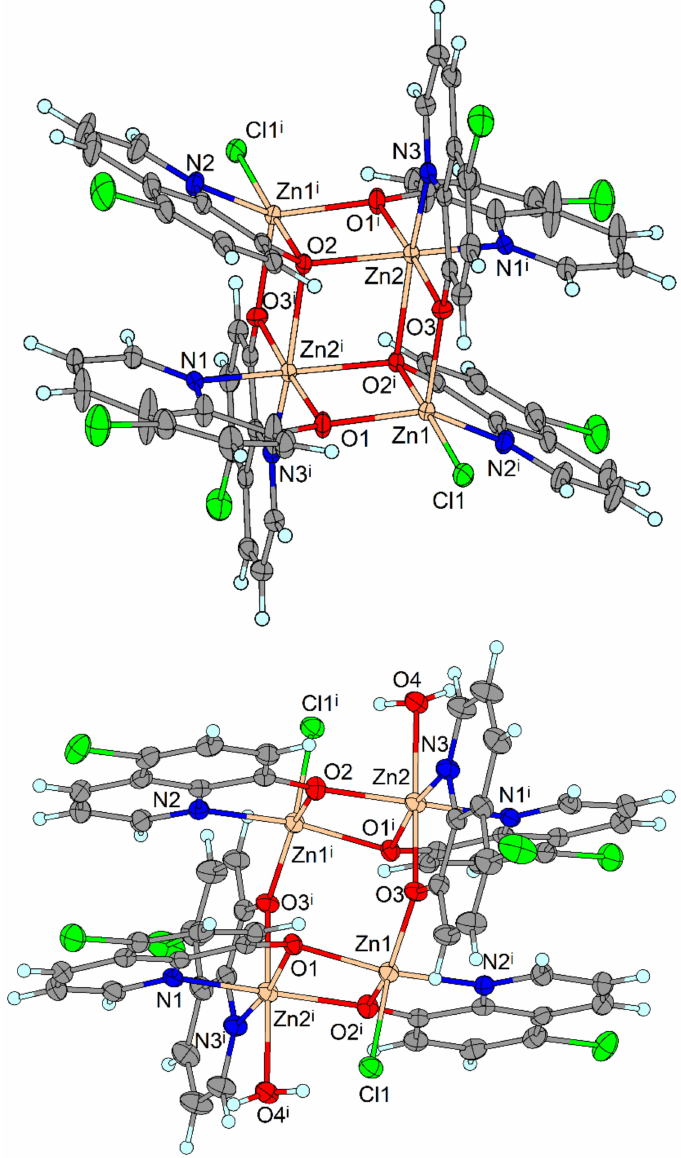
Figure 5. Molecular structure of 1 (up) and 2 (down). Solvated DMF molecules are omitted, symmetry code: i = − x , − y + 1, − z + 1. Displacement ellipsoids are drawn at 50%